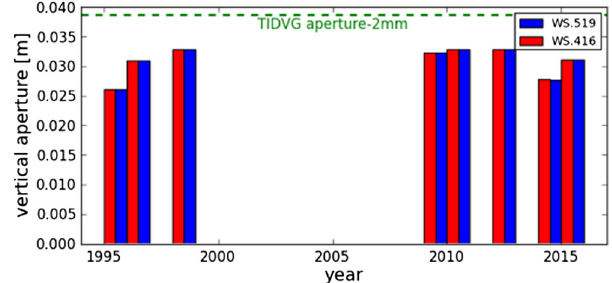
FIG. 9. Evolution of the measured SPS vertical aperture from 1995 to 2015. The extent of the transverse particle distribution of a blown up beam is evaluated with wire scanners as a measure of the global aperture. The measurements with two wire scanners are compared and translated to the location of the known SPS aperture bottleneck